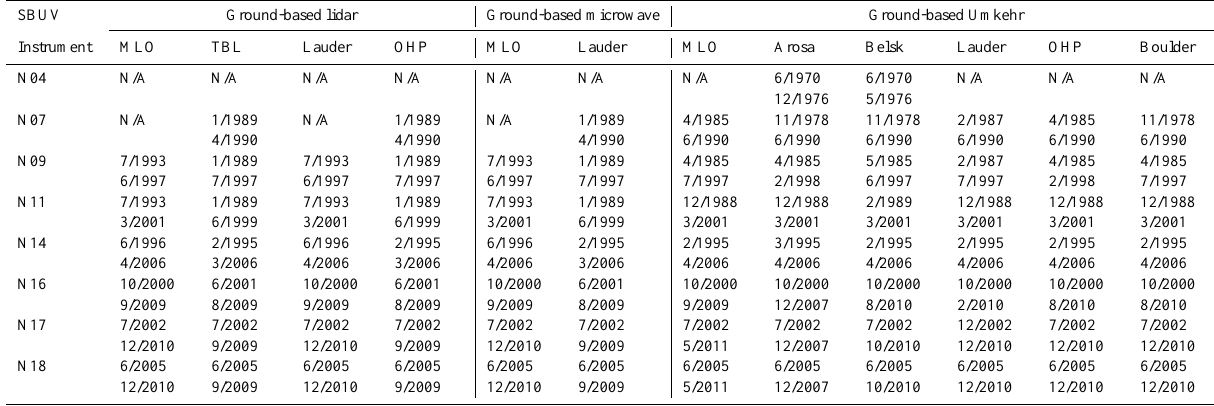
Table 1. Overlapping time periods for individual SBUV instruments with a variety of ground-based instruments (mm/yyyy). SBUV Ground-based lidar Ground-based microwave Ground-based Umkehr Instrument MLO TBL Lauder OHP MLO Lauder